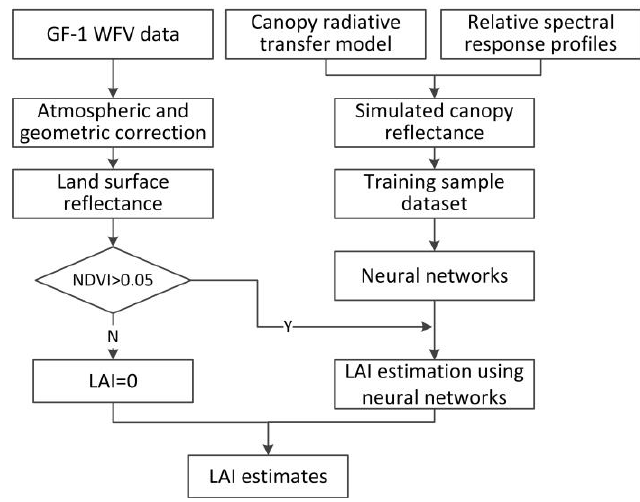
Figure 2. Flowchart of the leaf area index (LAI) estimation algorithm for GF-1 WFV data.